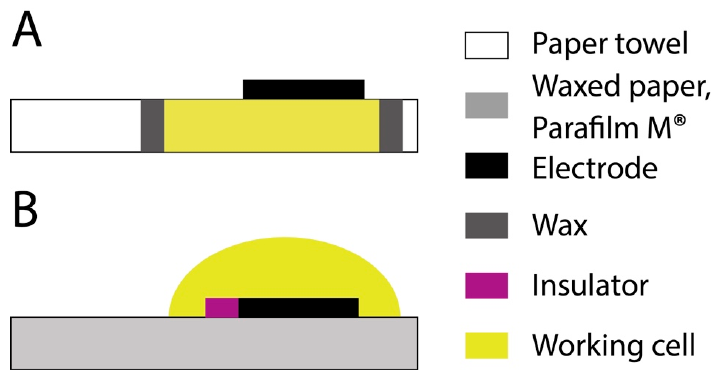
Figure 4. Experimental configurations of electrodes that have been screen-printed onto ( A ) paper towel and ( B ) waxed paper and Parafilm M ® .